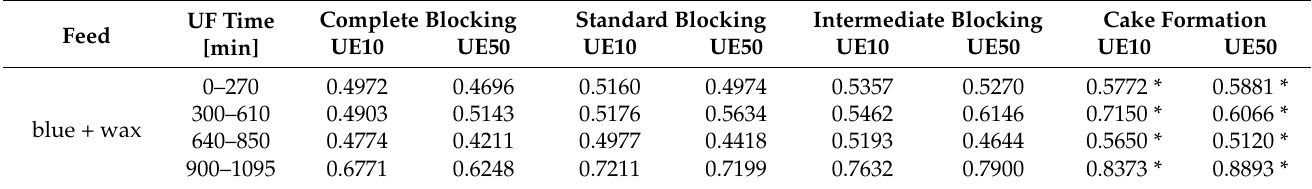
Table A4. Coefficient of determination (R 2 ) Hermia’s model. The wastewater concentration by UF process (Figure 12).